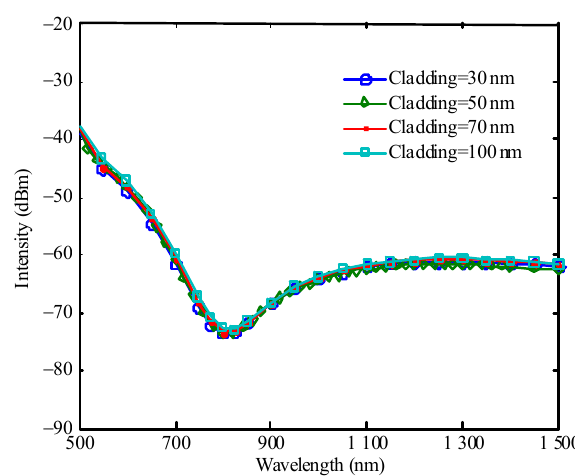
Fig. 5 SPR spectra with different thicknesses of the remaining cladding near the fiber core (Au film thickness =50 nm, air ring thickness =50 nm, and n a